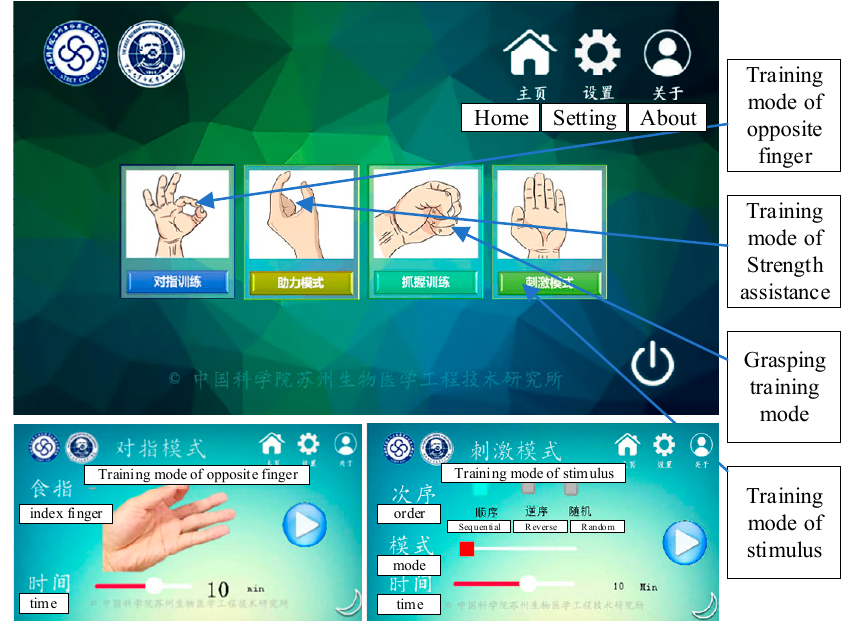
Figure 7. The control software interface of the rehabilitation robot.